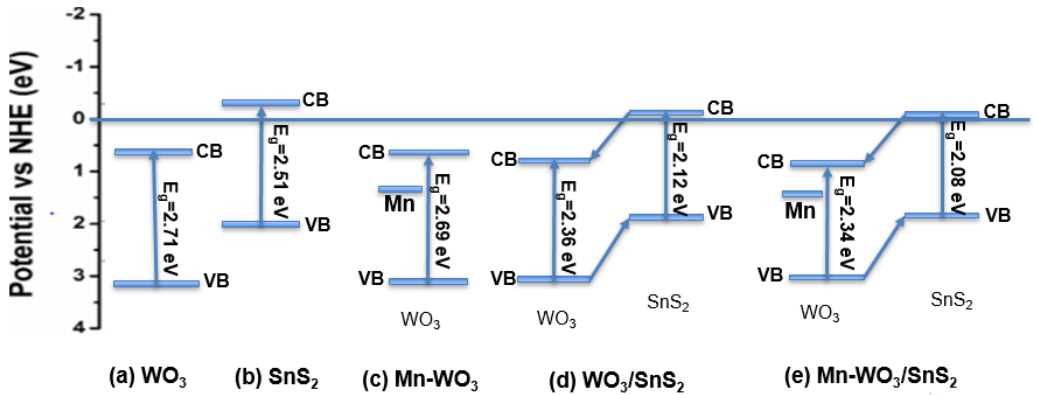
Figure 5. Diagram of the band gap , valence band and conduction band edge positions vs. the NHE of